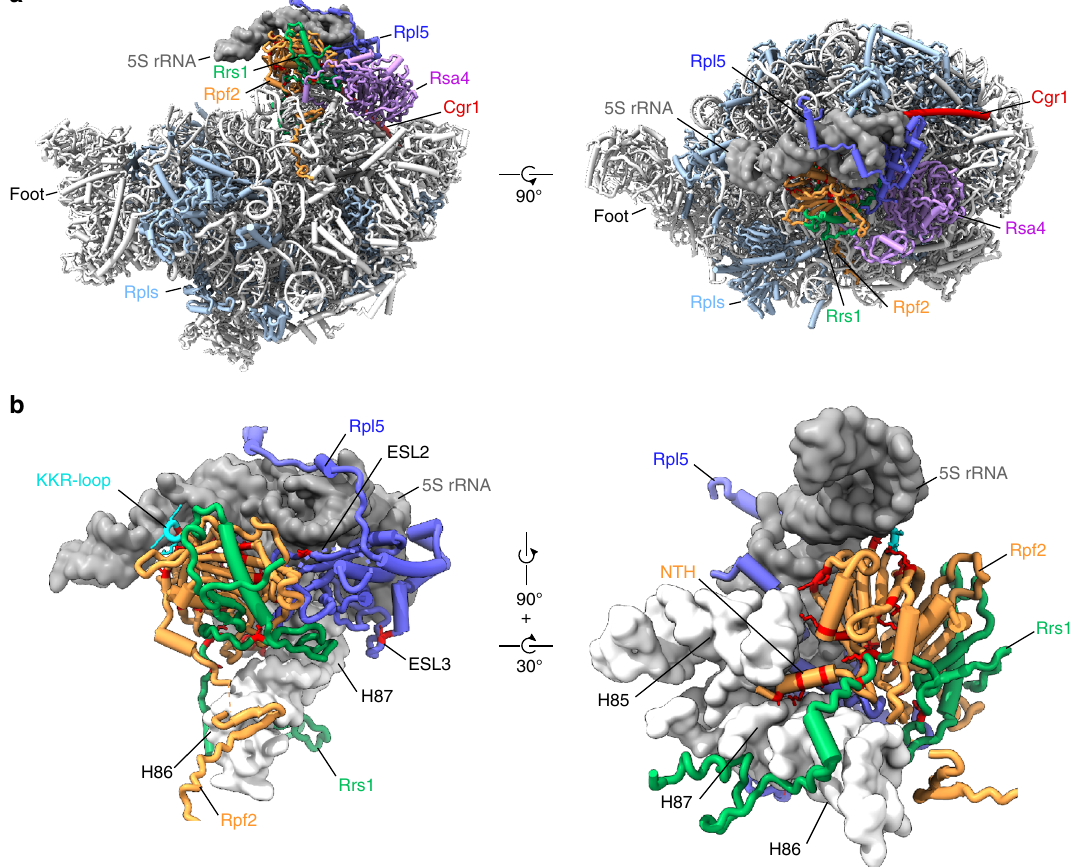
Fig. 4 cgr1 Δ suppressor mutations in RPF2 , RRS1 and RPL5 destabilize the unrotated 5S RNP on the pre-60S particle. a Overview of biogenesis factors Rpf2 (orange), Rrs1 (green), Rsa4 (purple), Cgr1 (red) and the ribosomal protein Rpl5 (dark blue) on the Nog2 particle (PDB: 3jct, 20 ) in the front and top view. Ribosomal proteins are shown in light blue and 5S rRNA as a dark grey surface model fi ltered at 6 Å resolution. b Positions of cgr1 Δ null suppressor mutations (red) displayed with surface models of the 5S rRNA (dark grey) and helices H83 to H87 (nucleotides 2650 – 2754) of the 25S rRNA (light grey). The KKR-loop of Rpf2 is highlighted in cyan. ESL2 and ESL3 mark the eukaryotic-speci fi c loops 2 and 3 of Rpl5, NTH marks the N-terminal helix of